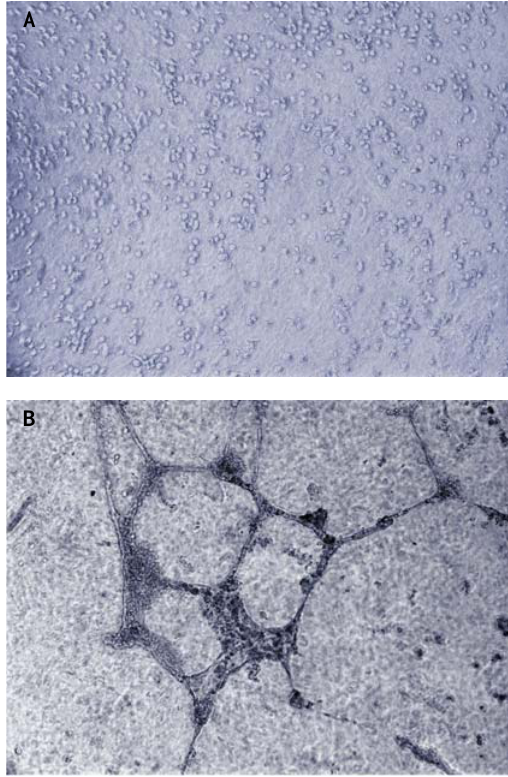
Fig. 3 - Ensaio de formação de túbulos capilares de células CD133+ diferenciadas in vitro . Fotomicrografia de: (A) células imediatamente após o plaqueamento apresentando morfologia arredondada e espalhadas pela superfície aleatoriamente (B) células após 24 horas apresentando estruturas semelhantes a túbulos capilares bem formadas